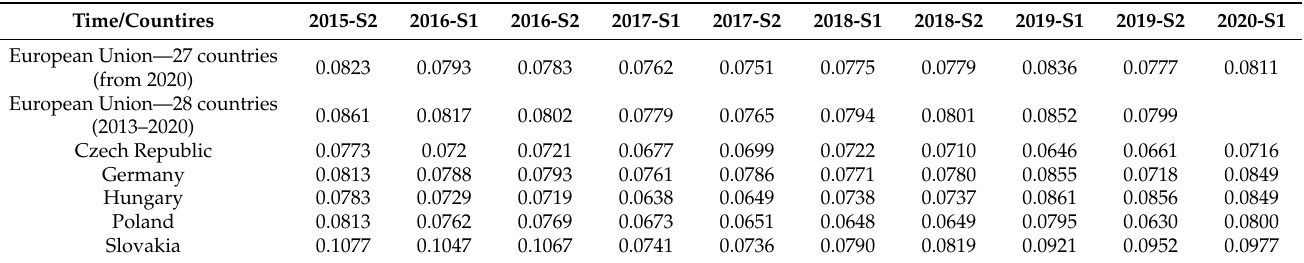
Table 8. Electricity prices for non-household